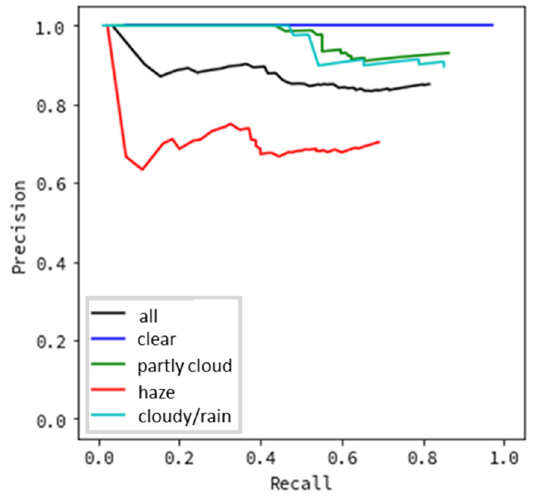
Figure 6. Detection precision by type of weather (including categorization).